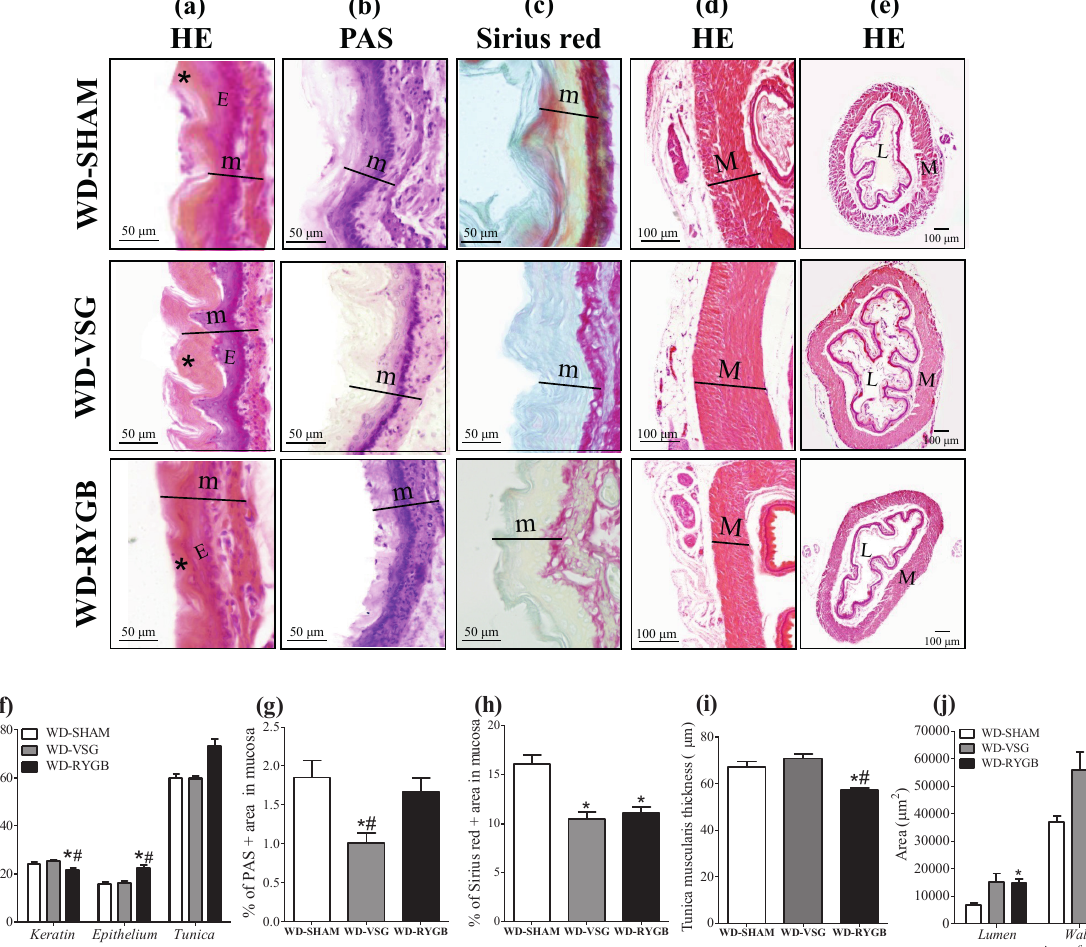
Figure 3. Representative images of 5-μm-thick sections of the upper esophagus of WD-SHAM, WD-VSG and WD- RYGB rats at 3 months after operations. Sections were stained with HE (a, d and e; * = keratin layer; E = epithelium layer; m = tunica mucosa; M = tunica muscularis; L = lumen), or periodic acid Schiff (PAS; B; m = tunica mucosa) or sirius red (C; m = tunica mucosa). Scale bars = 50 or 100 μm. Means ± SEM of the keratin layer, epithelium and tunica mucosa (f), percentage of PAS (g) or Sirius red (h) positive areas in tunica mucosa, thickness of tunica muscularis (i), and lumen and wall circumference area (j) of the upper esophagus; of the total tunica mucosa (d), tunica muscularis (e) and tunica adventitia (f) thickness in the upper esophagus of WD-SHAM (n = 5), WD-VSG (n = 5) and WD-RYGB (n = 5) rats. *different from WD-SHAM; #different from the other type of bariatric operation (Kruskal-Wallis followed by Dunns post test, P < (Fig. 5d and 5g), in this stomach region, did not differ between WD-VSG and WD-SHAM rats.